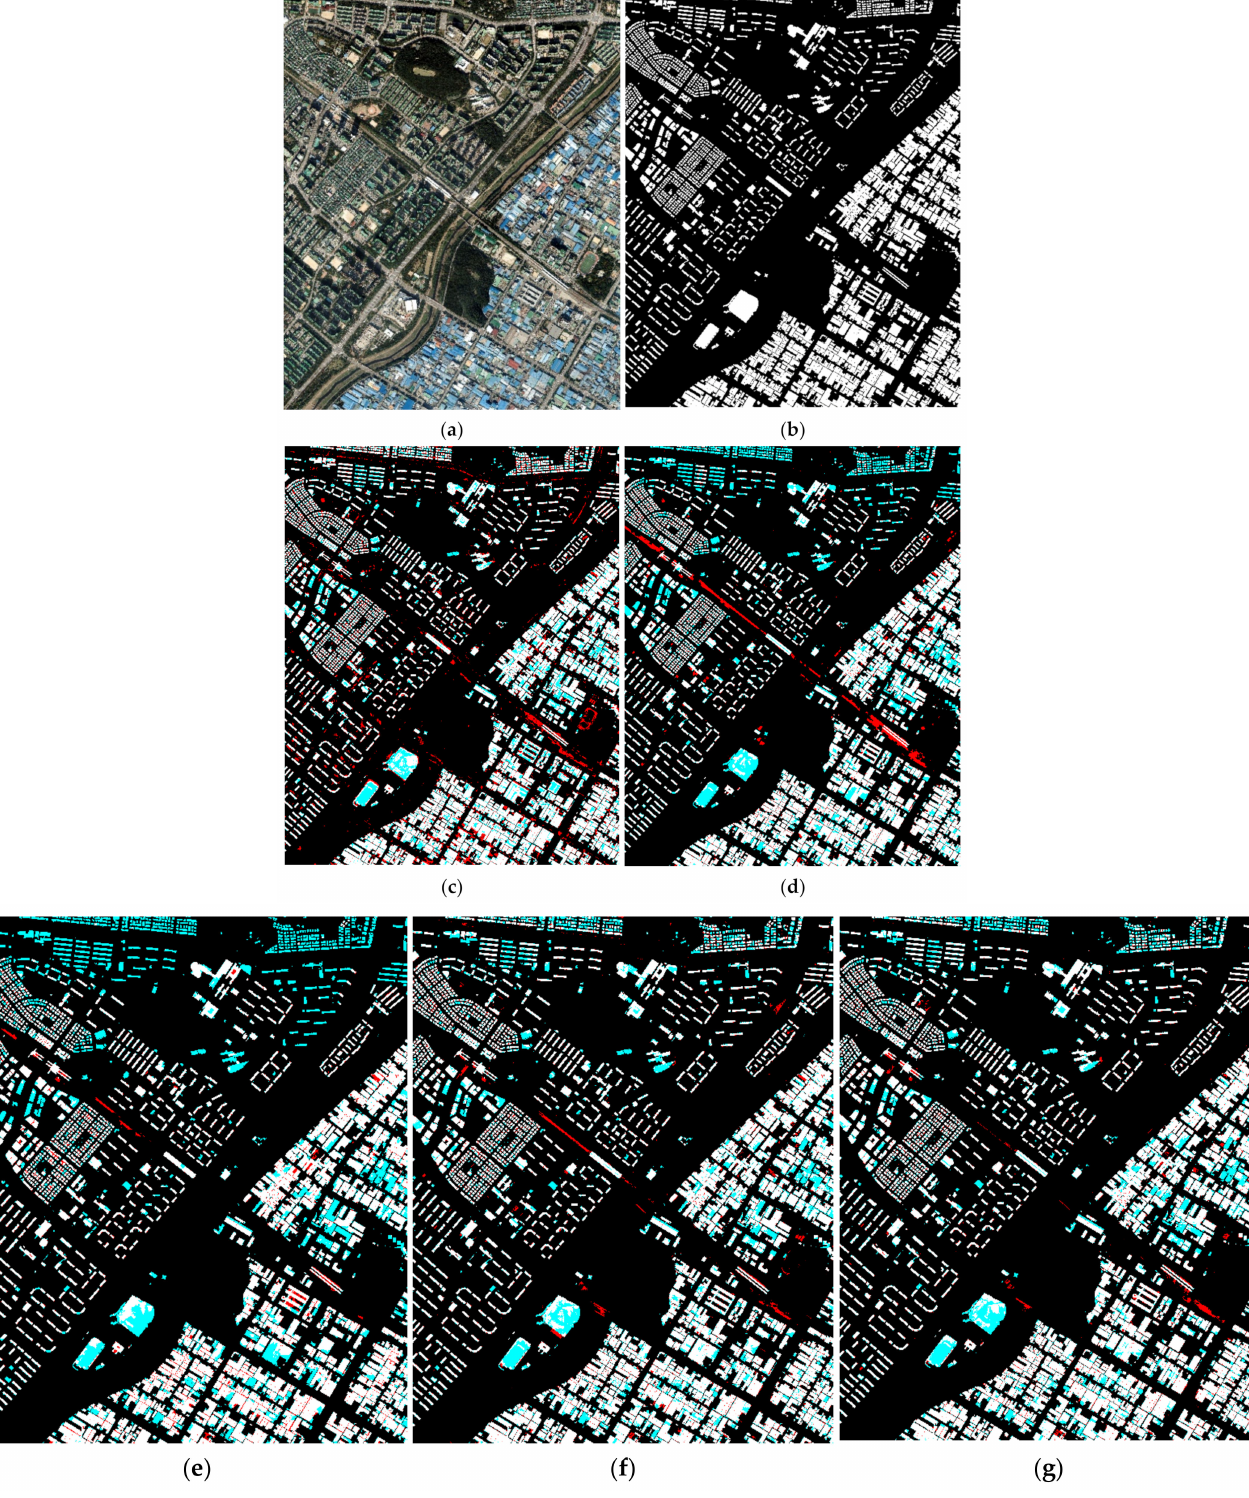
Figure 12. Building extraction results for site 2 according to each deep learning model. The red and cyan regions indicate false positives and false negatives, respectively. ( a ) Original image. ( b ) Ground-truth labels. ( c ) Results of SegNet. ( d ) Results of U-Net. ( e ) Results of FC-DenseNet. ( f ) Results of HRNet-v2. ( g ) Results of